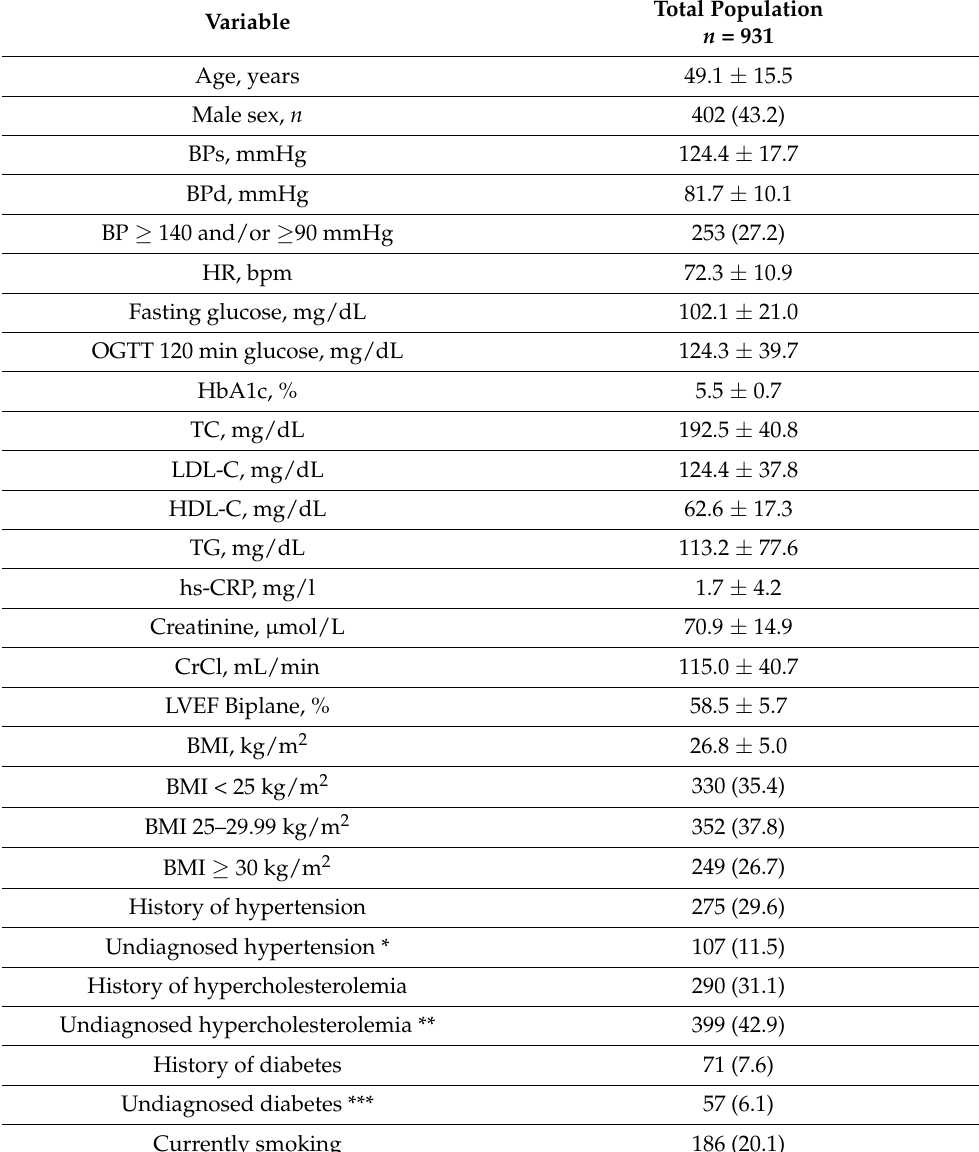
Table 1. The baseline characteristics of the analyzed